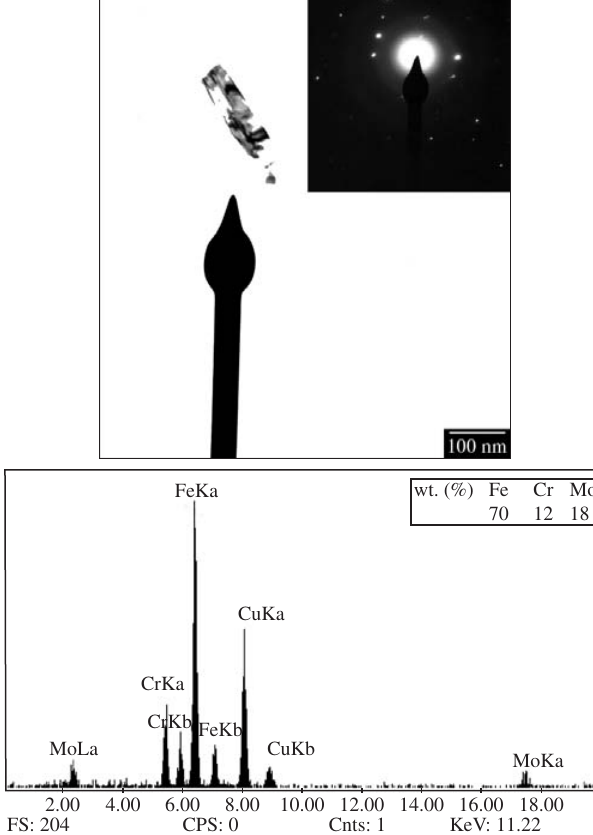
Figure 5. Representative result of the electron diffraction analysis of a se- lected area (carbide extraction replica) and of the EDS spectrum of elongated Fe MoC-type 2